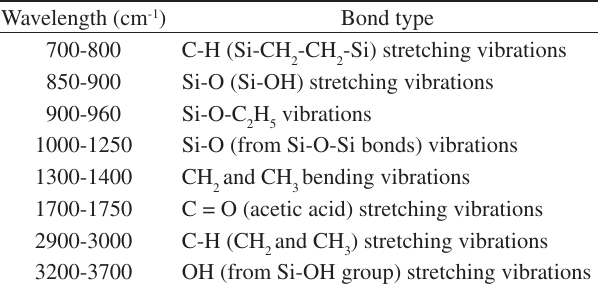
Figure 4. FT-IR spectra of the AA 2024-T3 sample with different treatments: a) Al-Ce-Si; b) Al-Ce-Si – sonicated; c) Al-Si; and d) Al-Si – Table 1. Absorption region and bond type found in silane films.